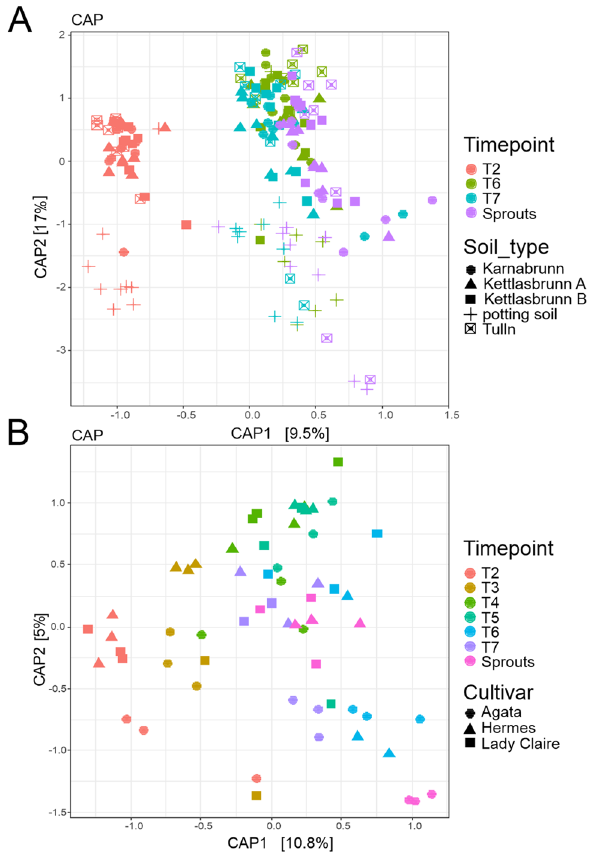
Figure 2. Constrained analysis of principal coordinates (CAP) of Bray–Curtis dissimilarities. CAP based on the V5–V7 regions of the 16S rRNA gene investigated for ( A ) tubers of the varieties (Agata, Lady Claire and Hermes) sampled at T2, T6 and T7 and ( B ) tubers of the varieties (Agata, Lady Claire and Hermes) sampled at T2-7 as well as sprout samples at T7. An overview of potato cultivars, soil types and sampling time points is shown in Fig.